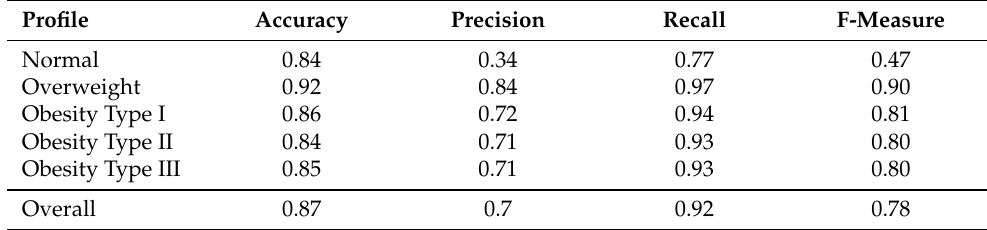
Table 4. Results obtained in the